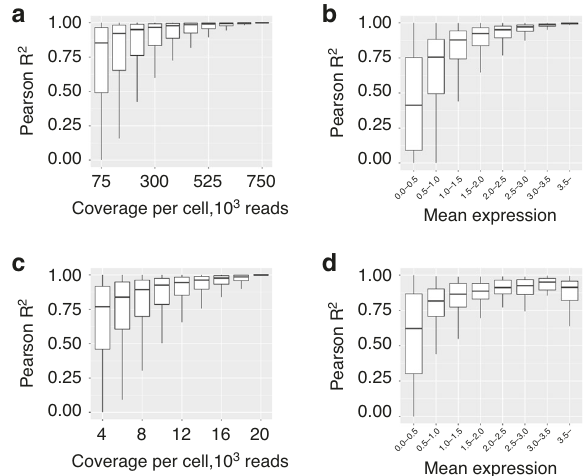
Fig. 1 Average R 2 between low-coverage and high-coverage gene expression estimates (Smart-Seq2 dataset, alpha cells). a Distribution of Pearson R 2 computed across all the genes at different levels of read coverage, Smart-Seq2 dataset. b Distribution of Pearson R 2 at 75,000 reads per cell strati fi ed by the expression level, Smart-Seq2 dataset. c Distribution of Pearson R 2 computed across all the genes at different levels of read coverage, 10× dataset. d Distribution of Pearson R 2 at 4000 reads per cell strati fi ed by the expression level, 10× dataset. The center line, bounds of box, and whiskers represent mean, 25th to 75th percentile range, and minimum to maximum range in all